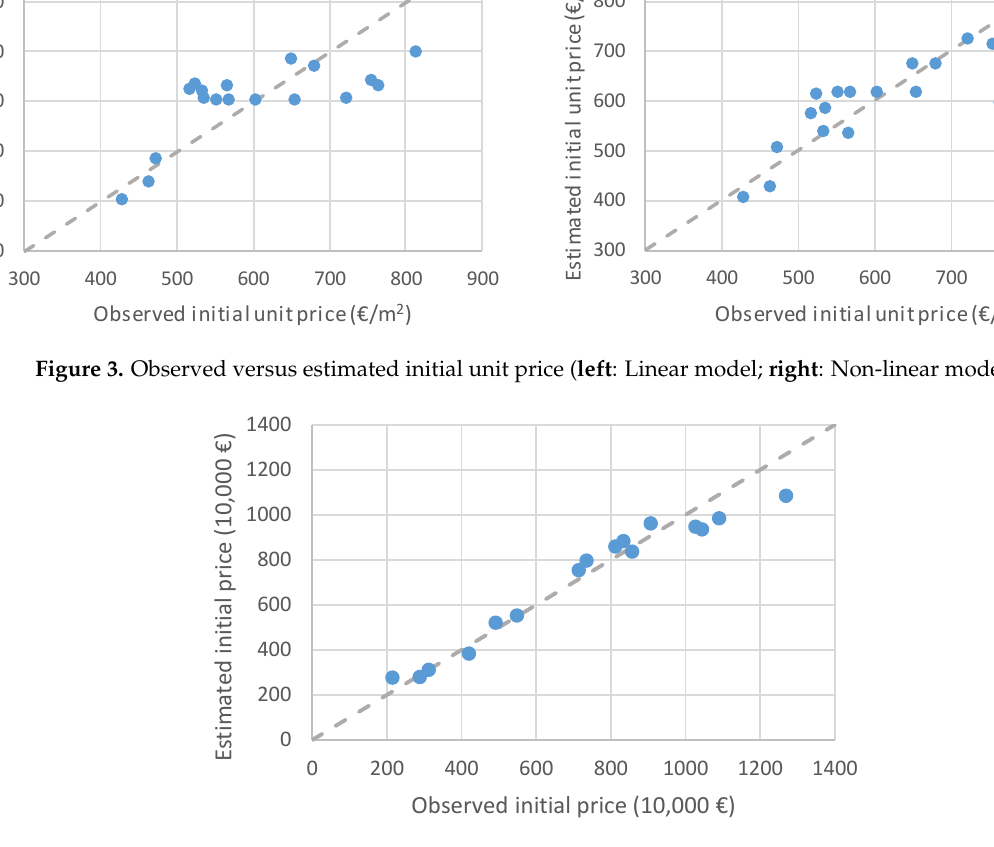
firm the statistical significance of the regression coefficients for a 95% confidence interval.